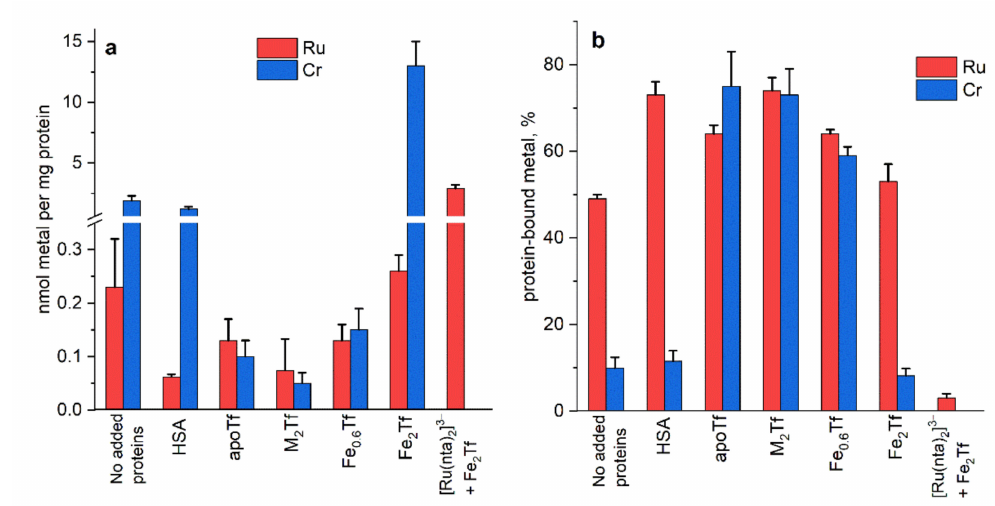
Figure 2. Comparison of cellular Ru uptake ( a ) and proportions of protein-bound Ru(III) ( b ) from Table 3 with the corresponding values for Cr(III) [30]. Unless indicated otherwise, the source of Ru(III) was KP1019 and that of Cr(III) was CrCl 3 · 6H 2 O. In all cases, the metal complexes (60 µ M) were pre-equilibrated with cell culture medium (DMEM with ~15 µ M BSA) in the presence or absence of added proteins (indicated on the X axis, 30 µ M) for 24 h at 310 K and 5% CO 2 . Prepared medium was added to HepG2 cells for further 24 h. The error bars represent mean values and standard deviations of three replicate